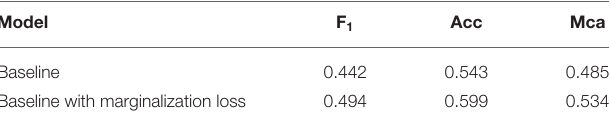
TABLE 3 | Ablation study for marginalization loss utilizing hierarchical label